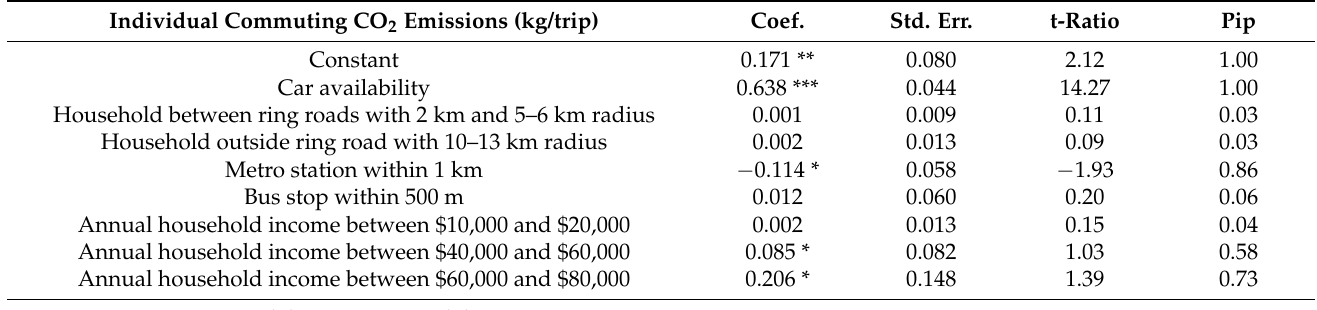
Table 4. Bayesian Model Averaging results in Xi’an